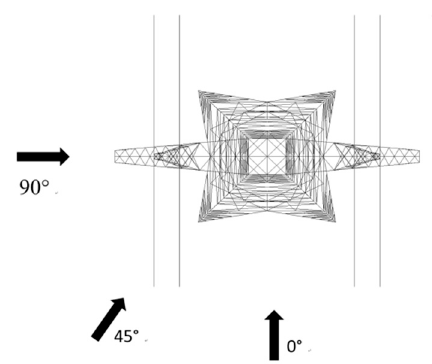
Figure 12. Schematic diagram of the wind attack angle.